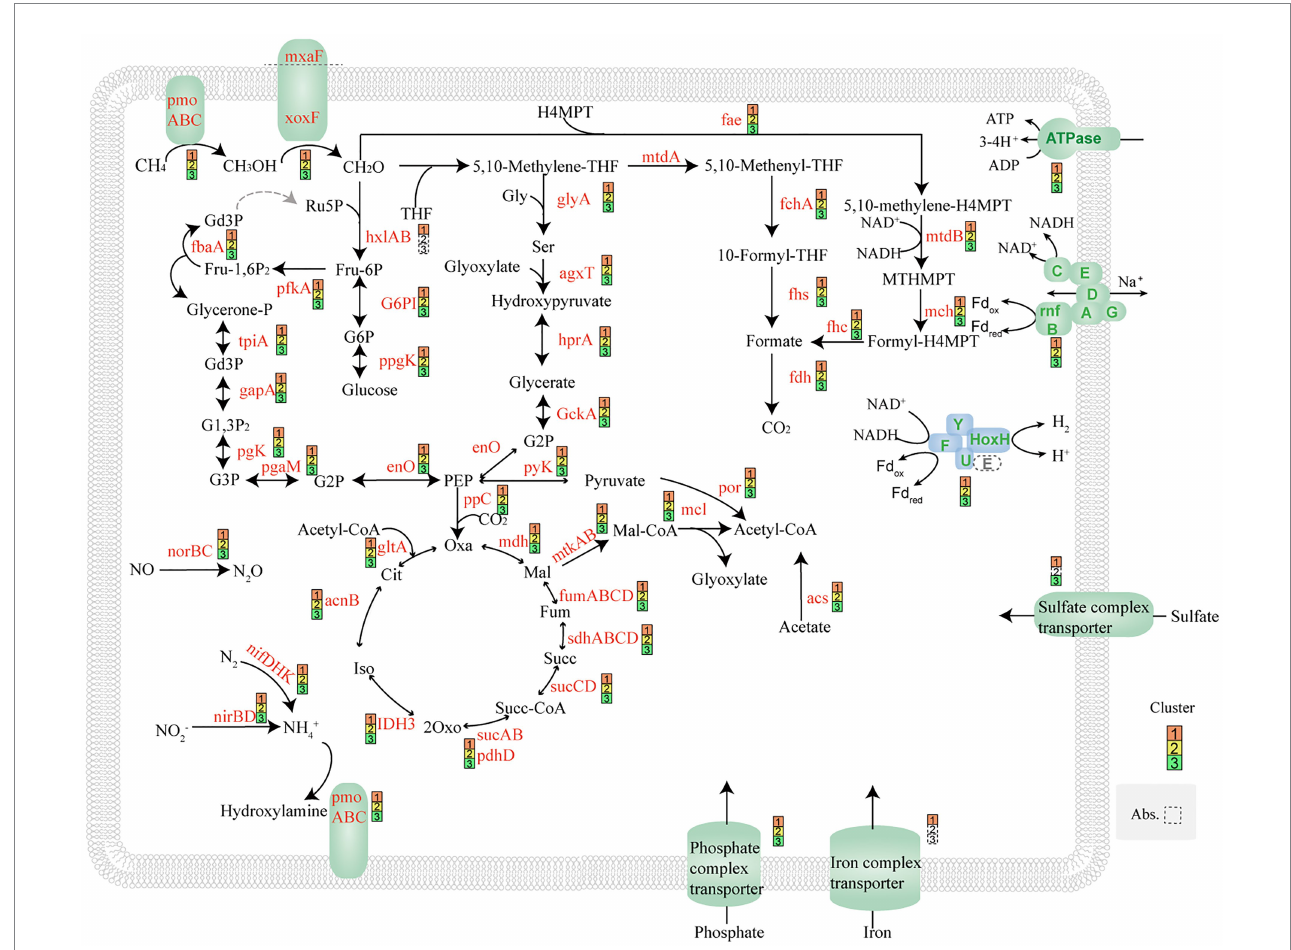
FIGURE 5 Proposed pathway by MAGs of Methylomonas based on metagenomics analyses. All MAGs use pmo complex to conduct the oxidation of methane to methanol. XoxF and mxaF dehydrogenase, which can catalyze methanol to formaldehyde, were found. In this study, MAGs have complete RuMP cycles, serine cycles, EMP, and TCA cycle pathways. NifDHK nitrogenase, NiRk dissimilatory nitrite reductase, NorB nitric oxide reductase, and HoxHY hydrogenase were also found in